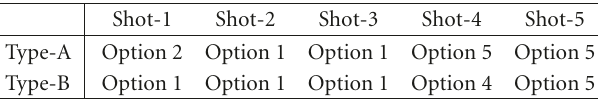
Table 6: An example of content-adaptive scaling option selection for di ff erent subject